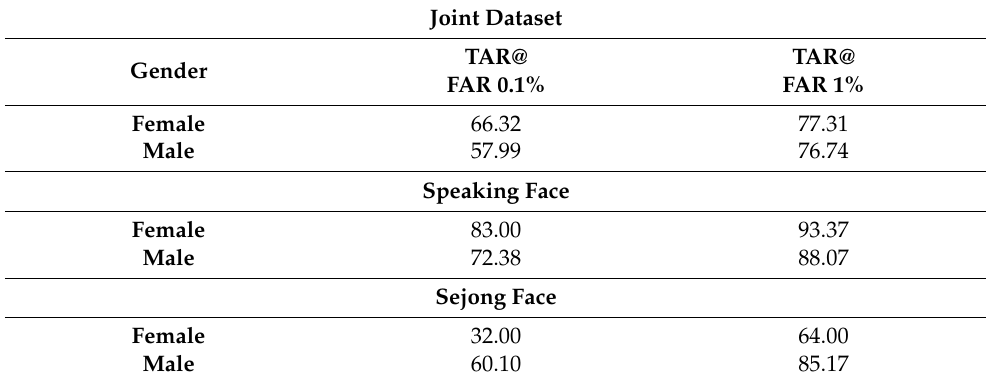
Table 10. Gender-divided performance of the triple triplet method with a thermal anchor image.